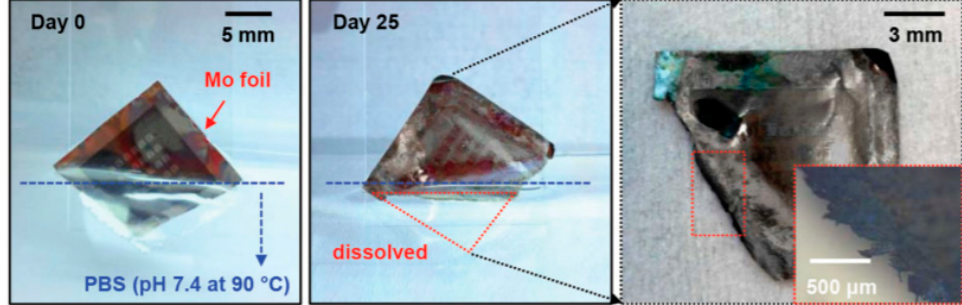
Figure 12 . Dissolution of a transistor array on a Mo foil (5 μ m thick) partially immersed in phosphate buffer solution (PBS, pH 7.4) at 90 °C. Device in its initial state (left) and partially dissolved after 25 days (middle). Magnified (right) and microscope (inset) images show full dissolution of the immersed area and partial dissolution at the edge. Addapted from [45] with permission. Copyright © 2015 Wiley and Sons.